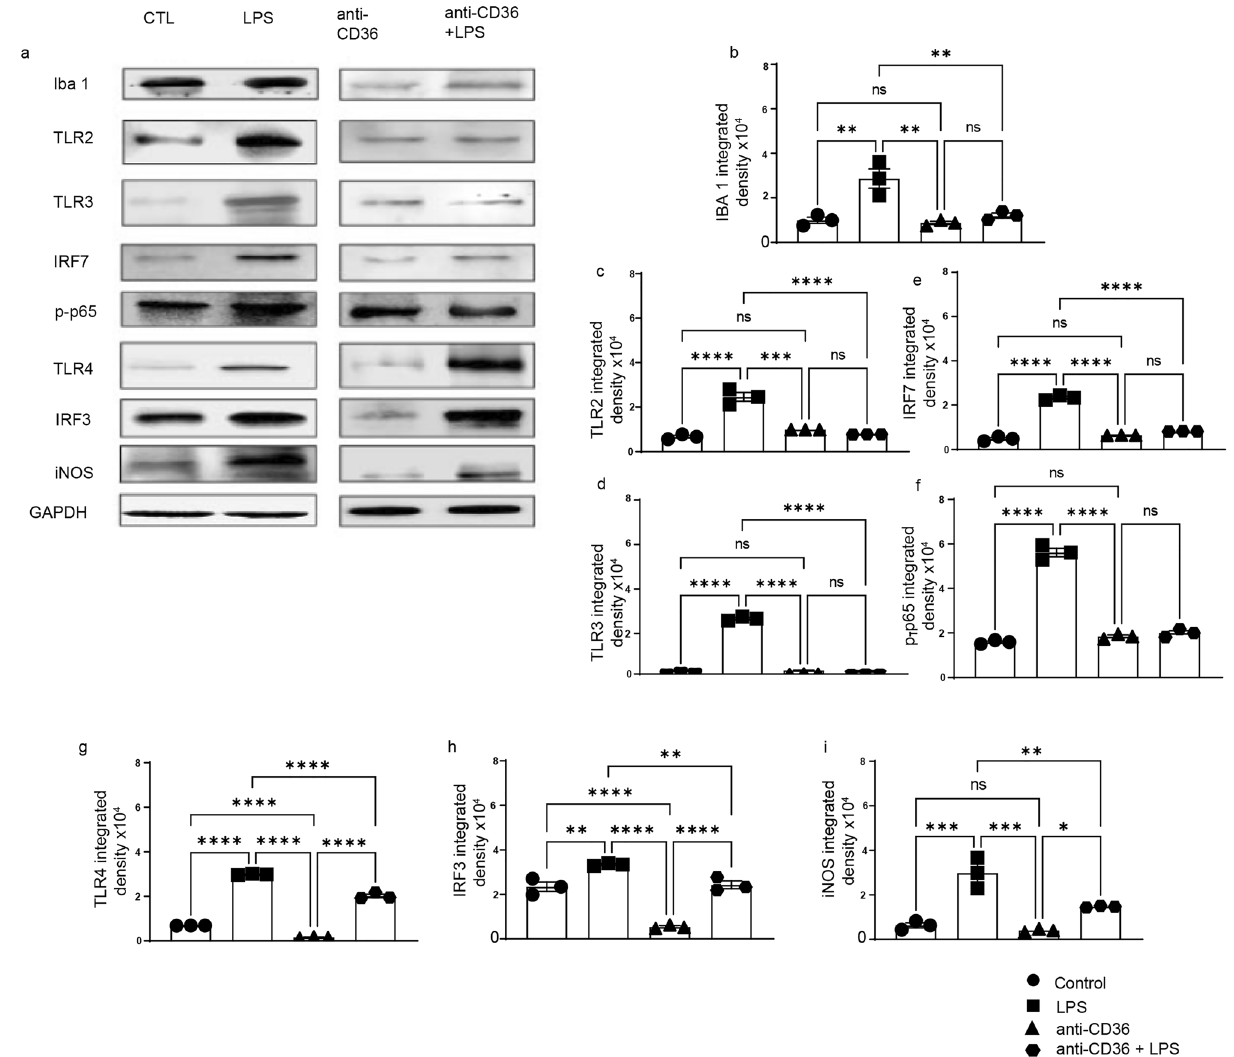
Figure 5. Blocking CD36 in human immature microglia affects the TLR3, TLR2-IRF7 but not TLR4/IRF-3 pathway. ( a ) Western blot of total protein lysates of HMC3 cells treated with anti-CD36 antibody, followed by LPS treatment after 24 h. Expression levels of ( b ) Iba-1, ( c ) TLR2, ( d ) TLR 3 along with ( e ) IRF 7, ( f ) p-P65, ( g ) TLR 4, ( h ) IRF-3, ( i ) iNOS were analysed and quantified. GAPDH was used as loading control. LPS treatment increases expression levels of all measured proteins while pre-treatment withanti-CD36 antibody prevented increase in their expression levels. Expressions of ( g ) TLR 4 and ( h ) IRF-3 ( i ) were not affected by anti-CD36 antibody pre-treatment.. Entire data in the figure was presented as mean ± SEM and statistical significance between the groups was achieved using one-way ANOVA with Tukey multiple comparison test and depicted as ****p ≤ 0.0001; ***p ≤ 0.001; **p ≤ 0.01 and *p ≤